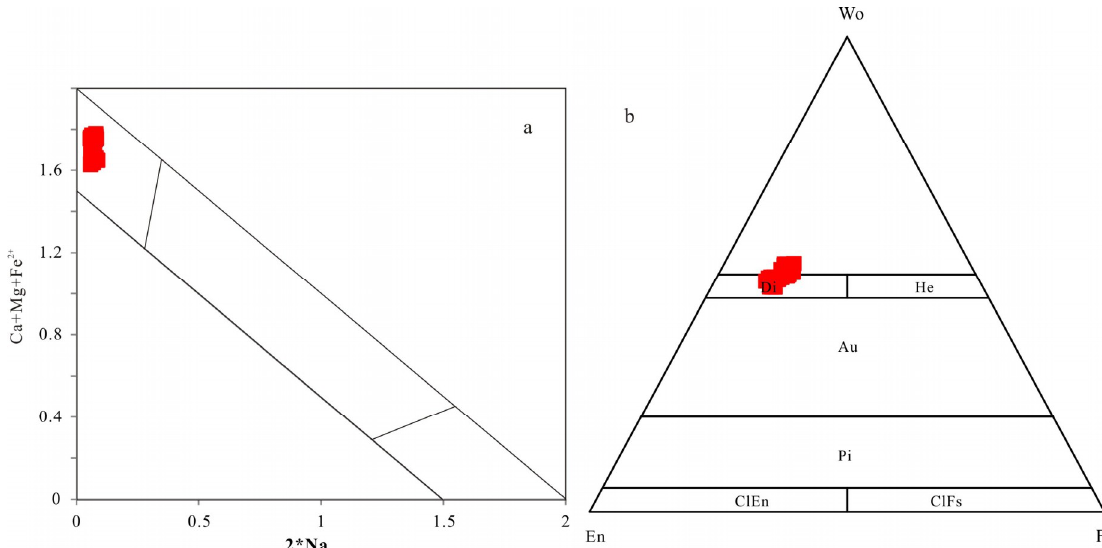
Figure 3. ( a ) Plot of a series discrimination diagram for clinopyroxenes; ( b ) Wo-En-Fs classification diagram for clinopyroxenes (after Morimoto [63]). Di-diopside, He-hedenbergite, Au-Augite, Pi-Pigeonite, ClEn-clinoenstatite, ClFs-clinoferrosilite.